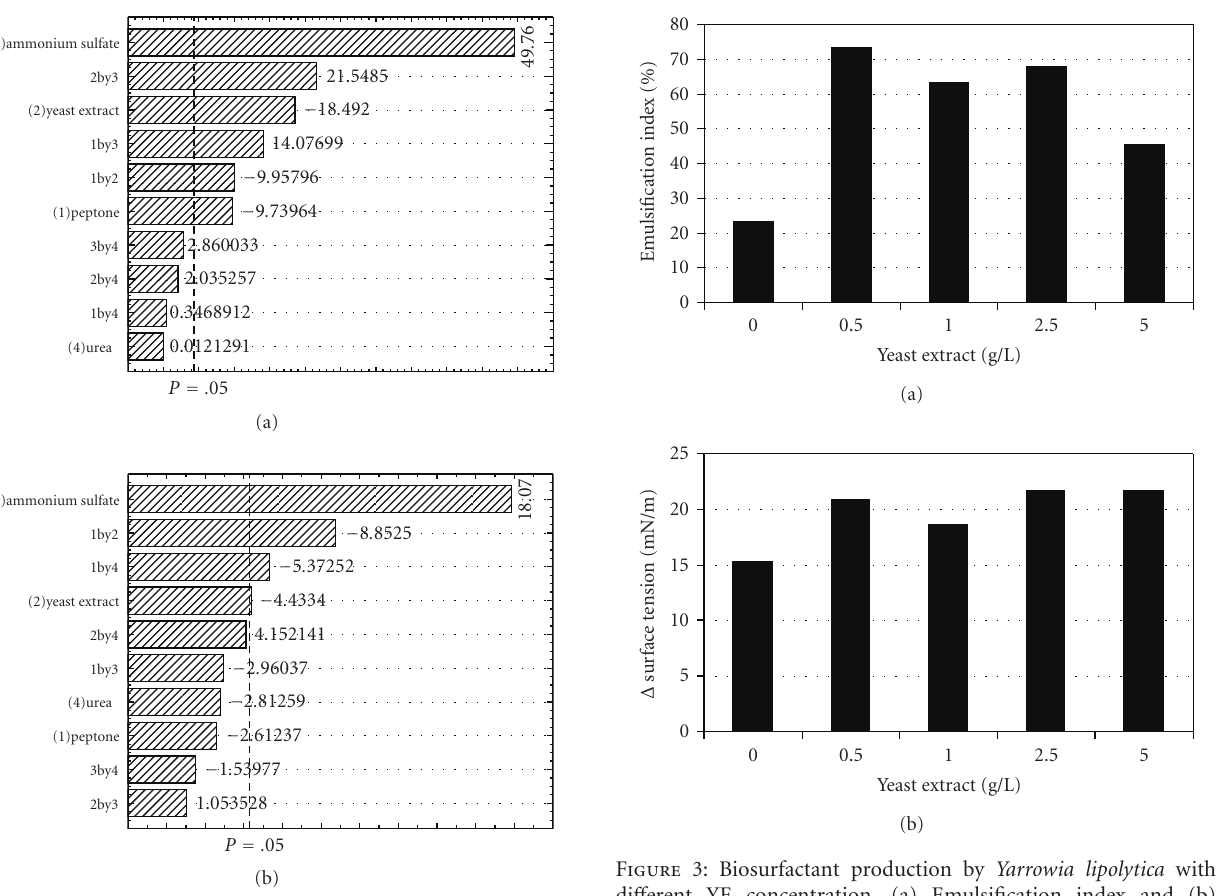
Figure 2: Pareto Chart of standardized e ff ects for emulsification index (a) and Δ surface tension (b) for the 2 4 full factorial design used in the optimization of nitrogen source. The point at which the e ff ects estimates were statistically significant (at P = .05) is indicated by the broken vertical line.